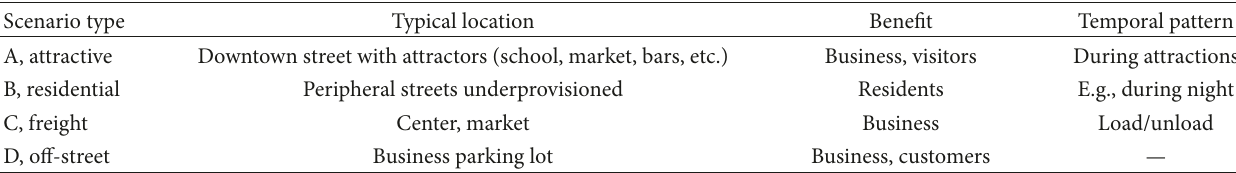
Table 1: Potential scenarios of